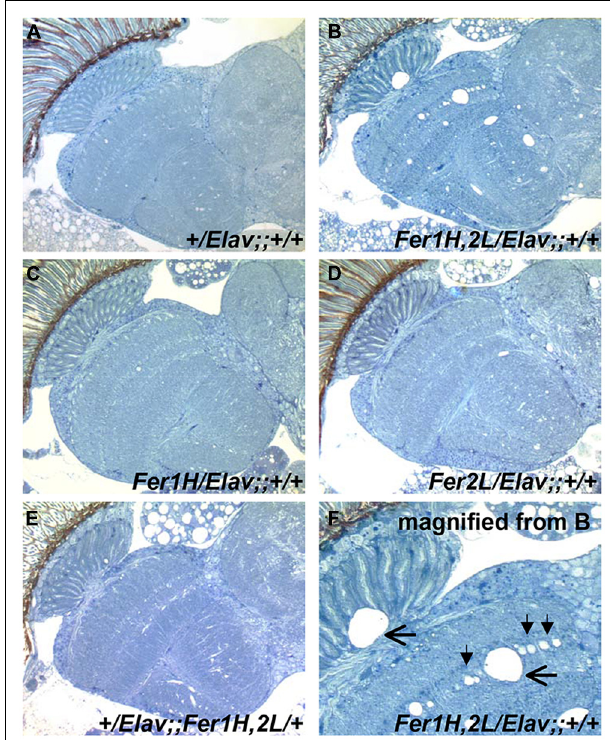
FIGURE 2 | Plastic embedded sections from 40-day old fly heads stained with toluidine blue. (A) Control flies show no signs of degeneration at this age (grown at 25 ◦ C). (B) Flies overexpressing ferritin derived from UAS-Fer1HCH, UAS-Fer2LCH ; + ; + mothers crossed to Elav-Gal4; + ; + fathers show extensive neurodegeneration. (C,D) Flies overexpressing single ferritin subunits show no signs of neurodegene- ration. (E) Flies overexpressing ferritin from the recombinant insertions on the third Chromosome also show no apparent neurodegeneration. (F) Close-up of image shown in (B) . Filled arrowheads denote the absence of single neuronal cell bodies lined up in the optic medulla. Horizontal arrows indicate areas of extensive neuronal